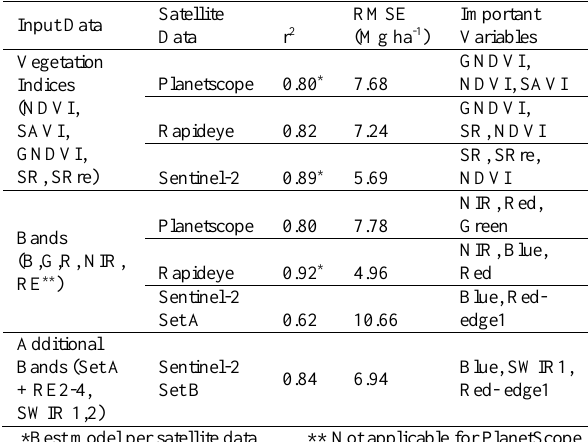
** Not applicable for PlanetScope Table 4. Important variables and correlation of measured above- ground biomass and satellite-based predictors using Multivariate Adaptive Regression Splines (MARS) The best predictive models were obtained with the multispectral bands of Rapideye with the highest r 2 value of 0.89 and smallest RMSE of 4.96 Mg ha -1 (Table 4). The three important variables of RapidEye are NIR (100%), Blue (42%) and Red bands (38%). This conforms to the results of Huang et al. (2017) which reported that NIR was the most important RapidEye band for biomass estimation. The best model for Sentinel-2 was generated with vegetation indices SR, SRre and NDVI (r 2 = 0.89; RMSE = 5.69 Mg ha -1 ) (Figure 3 - top). Simple ratio has 100% variable importance in the final model. Also known as Ratio Vegetation Index, SR do not have normal distribution compared to indices such as NDVI. High efficiency of SR as biomass predictor is commonly observed in areas with closed and dense vegetation cover, including biomass estimates in tropical forests (Clerici et al., 2016). SR is also an important variable in the RapidEye index- based model and in the two best linear regression models. Table 3. Linear correlation of measured above-ground biomass Meanwhile, NDVI is known to perform best in estimation of leaf and satellite-based predictors. Values of r 2 in bold text are biomass (Kross et al., 2015) and is usually a successful biomass significant with p > 0.001. predictor for a wide range of satellite